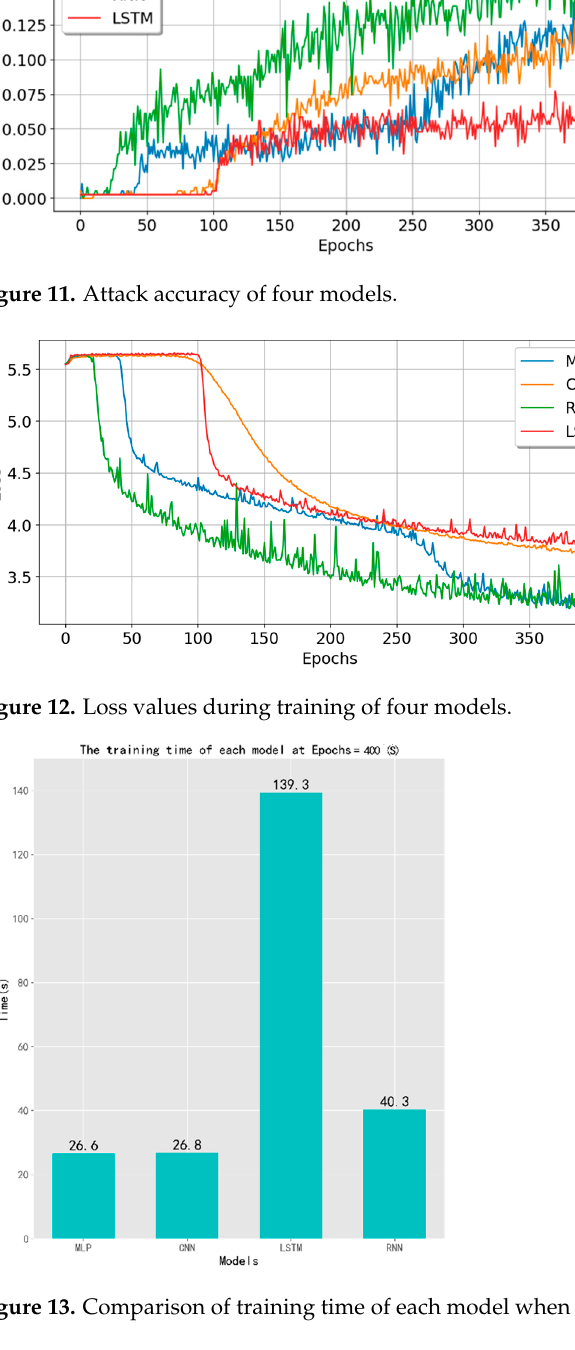
Figure 13. Comparison of training time of each model when epoch is 400.